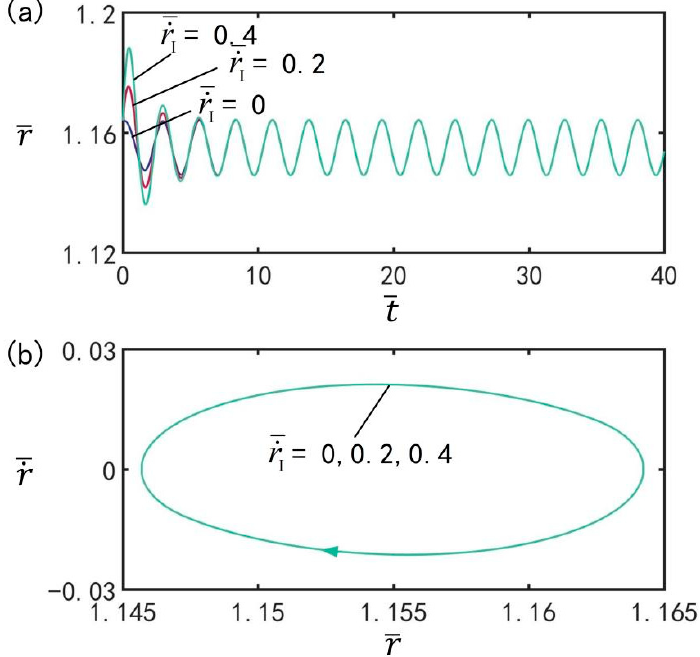
. r I on the beating of LCE balloon. ( a ) Time histories; ( b ) Limit cy- Figure 13. The effect of initial velocity Figure 13. The effect of initial velocity I r  on the beating of LCE balloon. ( a ) Time histories; ( b ) cles. The parameters are T on / T L = 0.5, T L = 2.7, I = 0.5, C 0 = 0.3, n I = 0.45 ( r I = 1.164 ) , V L = 0.05, Limit cycles. The parameters are = 0.18, and β = 0.14. The initial velocity does not affect the beating ρ = 0.16, p ext does not affect the beating amplitude.